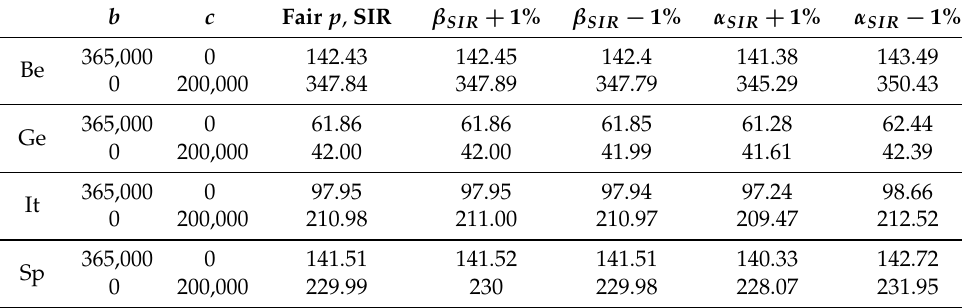
Table 5. Fair premium rates with the model (1). Duration T = 0.5 year and r =